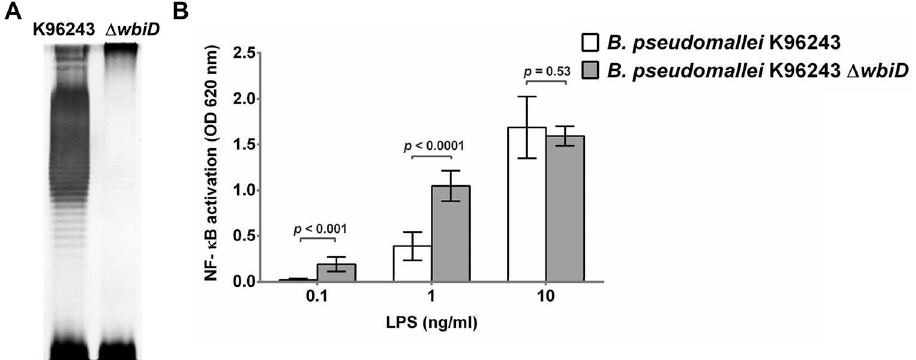
Fig 11. Purified LPS from B . pseudomallei strain K96243 and K96243 Δ wbiD . LPS was purified by a modified hot phenol-water extraction method. Five micrograms of LPS was run by SDS-PAGE electrophoresis followed by silver staining (A). Activation of NF- κ B in HEK-Blue hTLR4 cells by LPS at 0.1, 1 and 10 ng/ml of B . pseudomallei K96243 and K96243 Δ wbiD (B). NF- κ B activation was determined in the supernatant using a SEAP reporter assay. The data were calculated to account for the difference in weight of wild type LPS and Δ wbiD mutant LPS. Mean ± SD of two independent experiments were